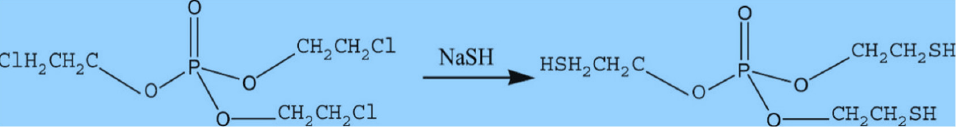
Figure 7. Synthesis scheme of TMEP.